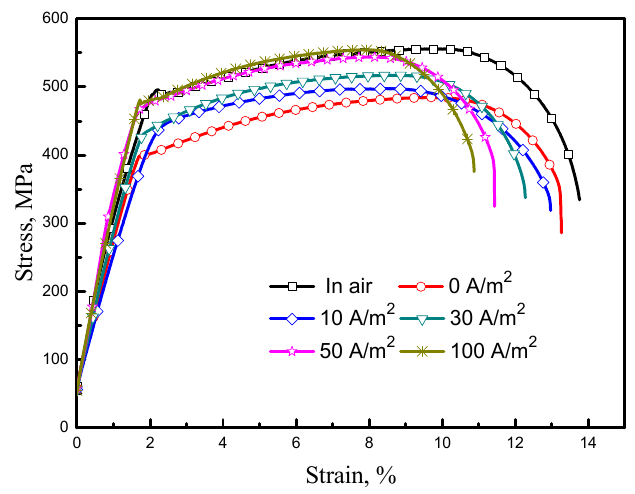
Figure 8. Stress–strain curves of the X70 steel after SSRT tests at various AC densities in simulated seawater.